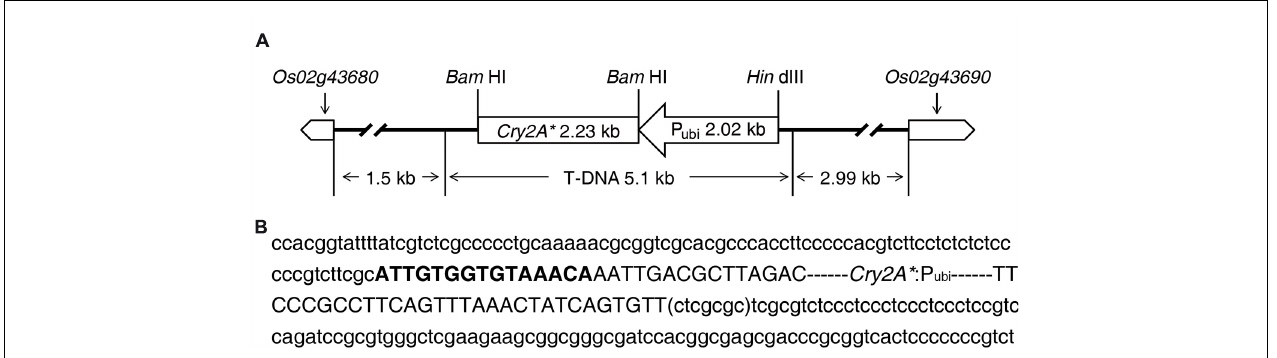
FIGURE 5 | Information of T-DNA integration site in transgenic line 8 − 30. (A) T-DNA inserted into rice chromosome 2 between gene Os02g43680 and gene Os02g43690 . (B) Nucleotide sequences of T-DNA integration site. The two flanking sequences of T-DNA are displayed in lowercase letter. The sequence in bracket is the deletion sequence of genome. The T-DNA sequence is shown in capital letter. Bold capital letters represent the truncated T-DNA left border (LB). T-DNA right border (RB) is missing in line 8 − 30.